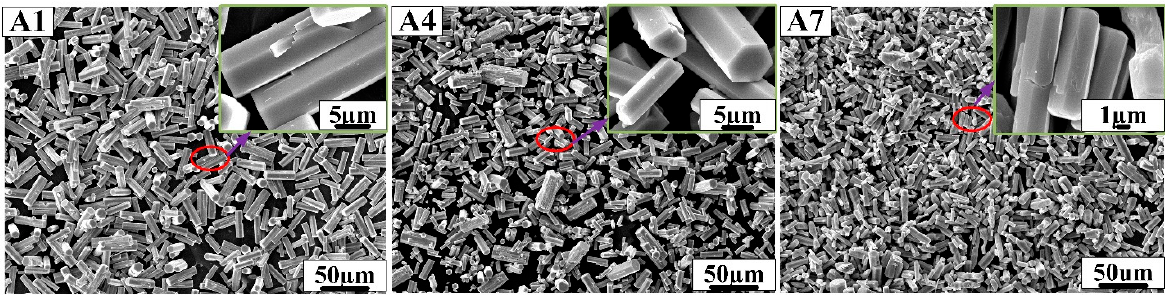
Figure 2. SEM morphology of samples A1, A4 and A7 prepared in hydrochloric acid solution.